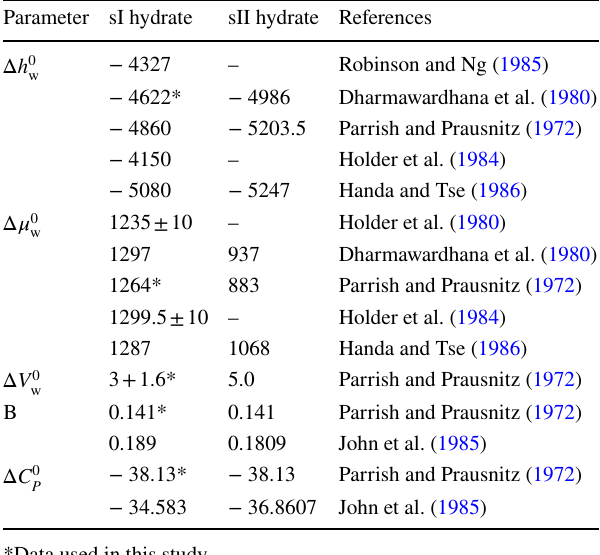
Table 4 Thermodynamic properties of liquid water and